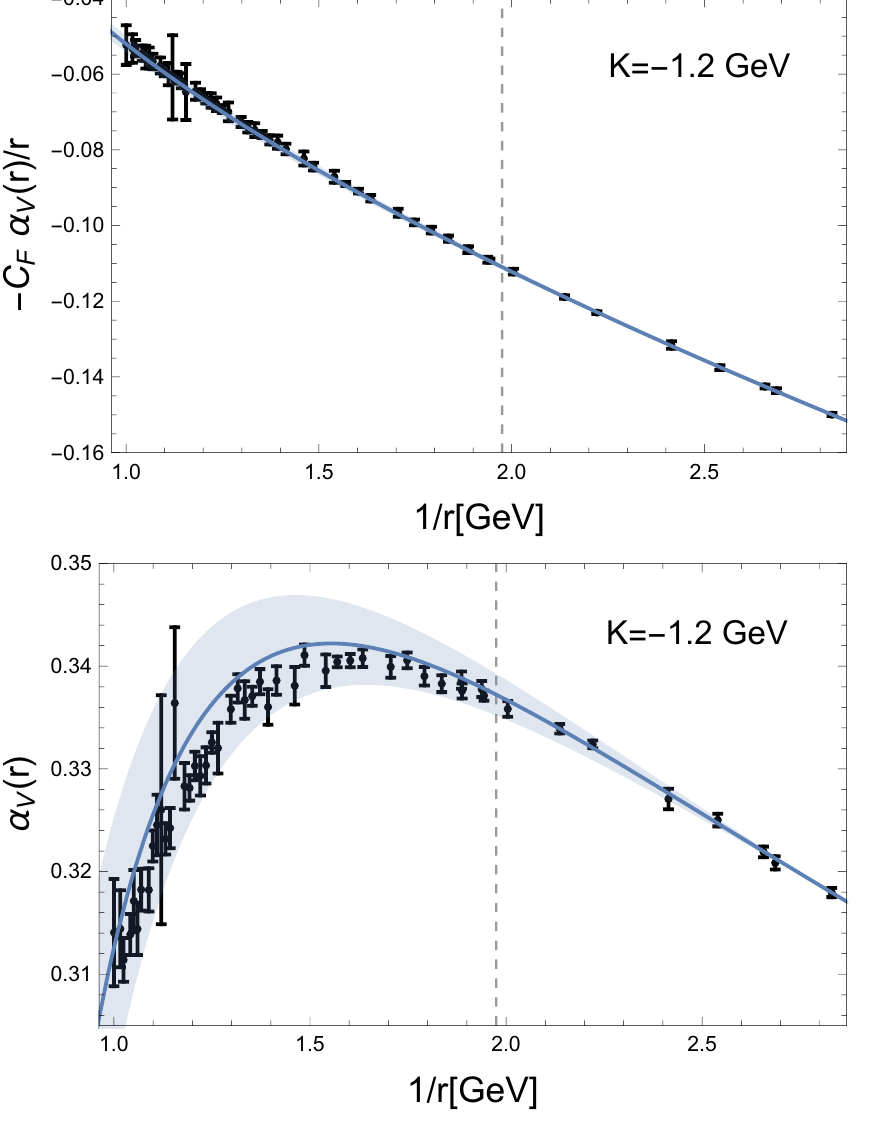
Figure 3 . Upper panel : (cid:0) C F (cid:11) V ( r ) 338(12) MeV and K = (cid:0) 1 : 2 GeV (solid blue line and blue band) versus the lattice points E latt ( r ) (cid:0) E latt ( r ref ) + K . Only points to the right of the vertical dashed line are included in the (cid:12)t. Lower panel : (cid:11) V ( r ) at NNNLL hyp with (cid:3) ( n f =3) blue line and blue band) versus the lattice points (cid:0) r the right of the vertical dashed line are included in the